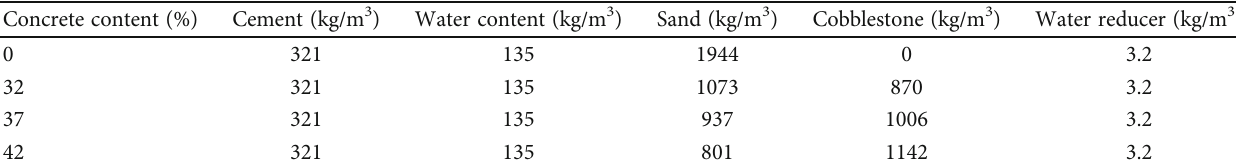
Table 1: Concrete mix